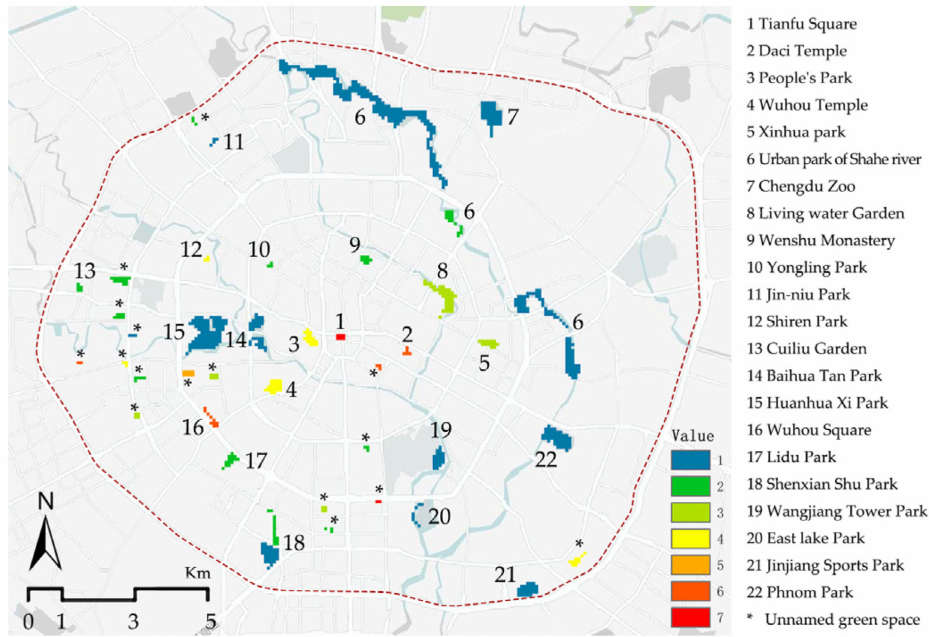
Figure 3. Spatial distribution of UGS vitality within the Third Ring Road of